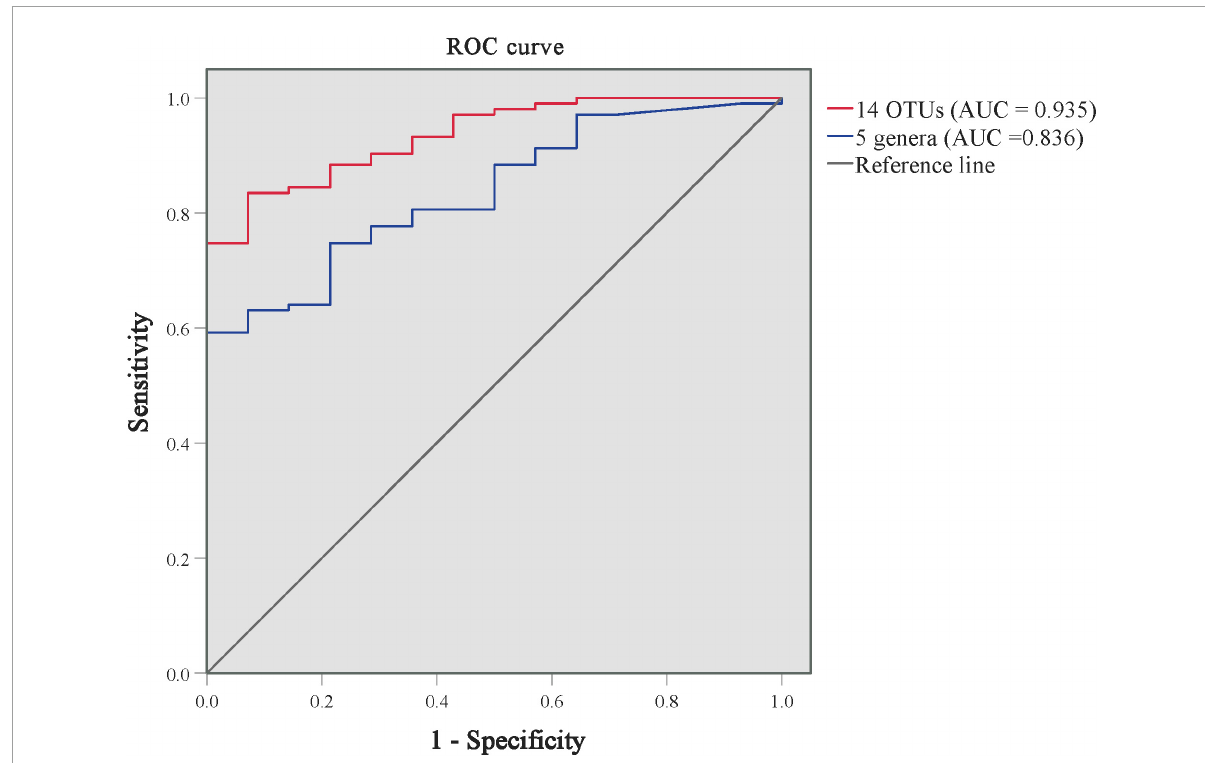
FIGURE4 ROC curves for distinguishing GP from PP groups using the models of predominant skin microbiota. The ROC curve of 14 predominant OTUs is in red, and the ROC curve of 5 genera is in blue. AUC, the area under the receiver-operating characteristic curve.